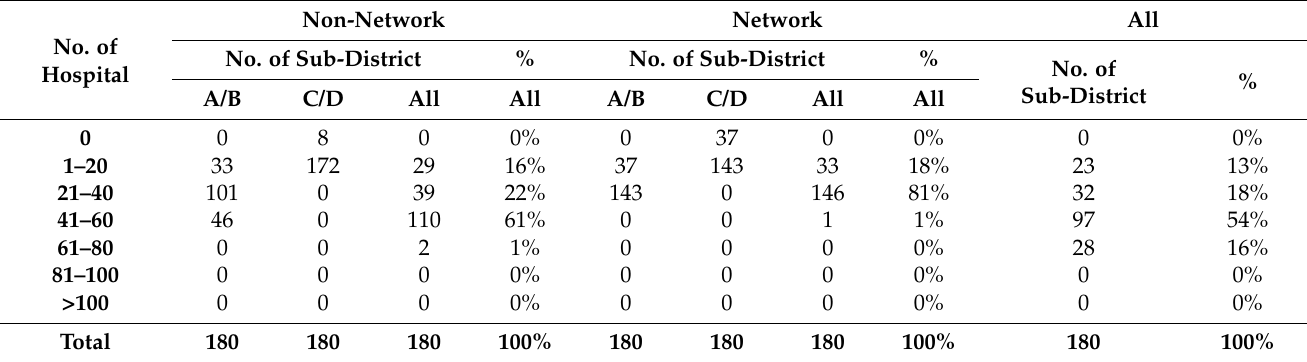
Table 5. Number of hospitals covered in each sub-district.